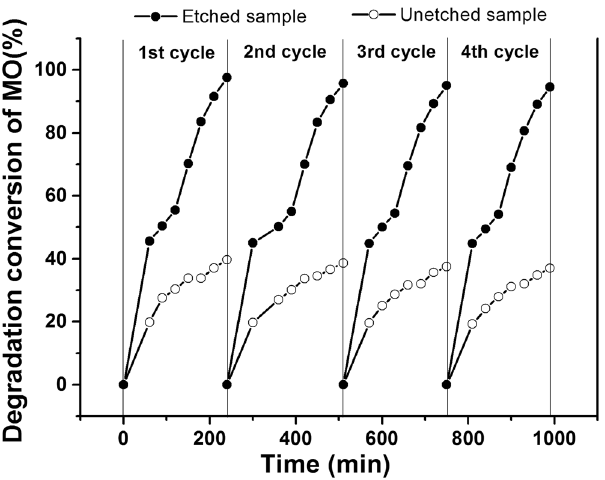
Figure 9. Long-term catalytic stability of the bulk Bi 2 Fe 4 O 9 and the flower-like Bi 2 Fe 4 O 9 spheres in repetitive experiments of MO degradation under UV light